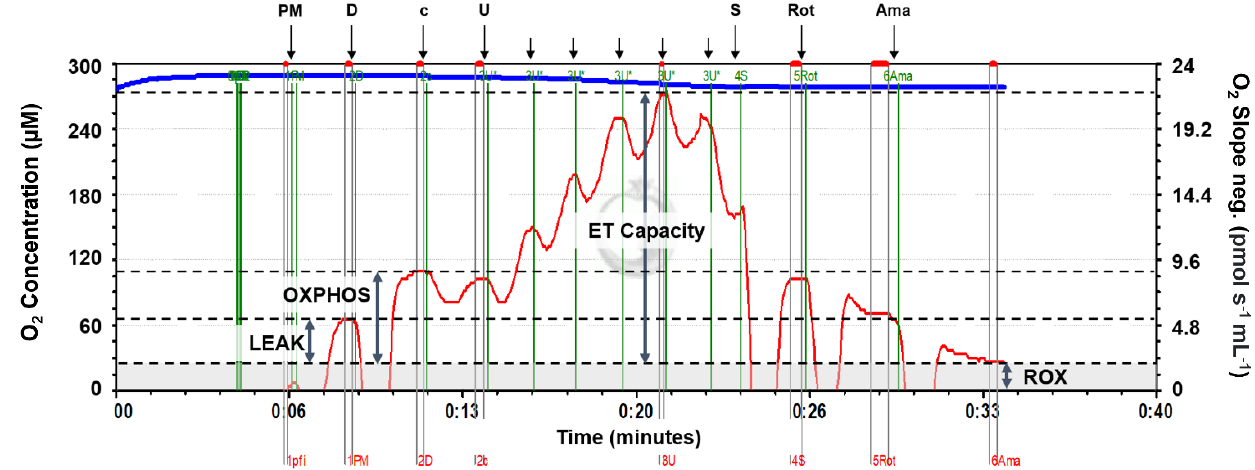
Figure 1. Annotated O2k Oxygraph. Example trace from the brain of a stickleback, following protocol described above. Blue line shows oxygen concentration, red line shows the oxygen flux. ROX, LEAK, OXPHOS and ET capacity respiration states labelled with double headed arrows. The point when each substrate/inhibitor was added is shown by arrows above the trace, and where oxygen flux reached equilibrium is shown in red below. PM = Pyruvate and Malate; D = ADP; c = Cytochrome c; U = Uncoupler (CCCP), added repeatedly at each shorter arrow until a max. value was reached; S = Succinate; Rot = Rotenone; Ama = Antimycin A.